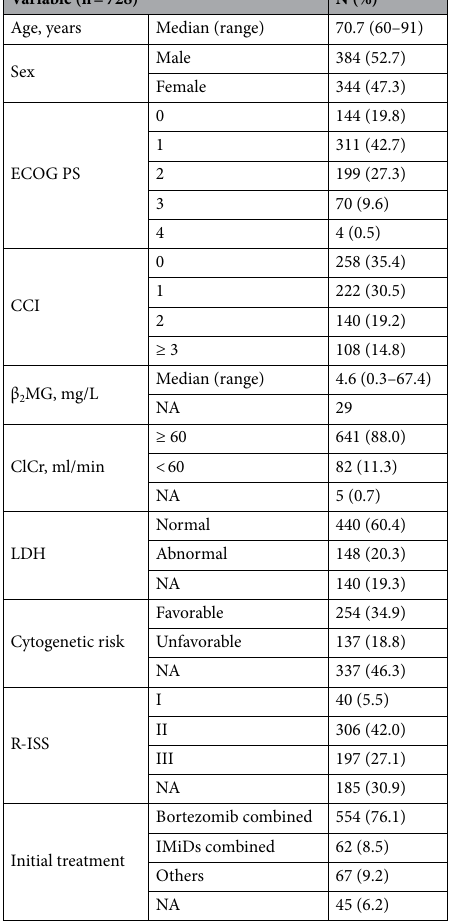
Table 1. Patients characteristics. ECOG PS , Eastern Cooperative Oncology Group performance status; CCI , Charlson comorbidity index;